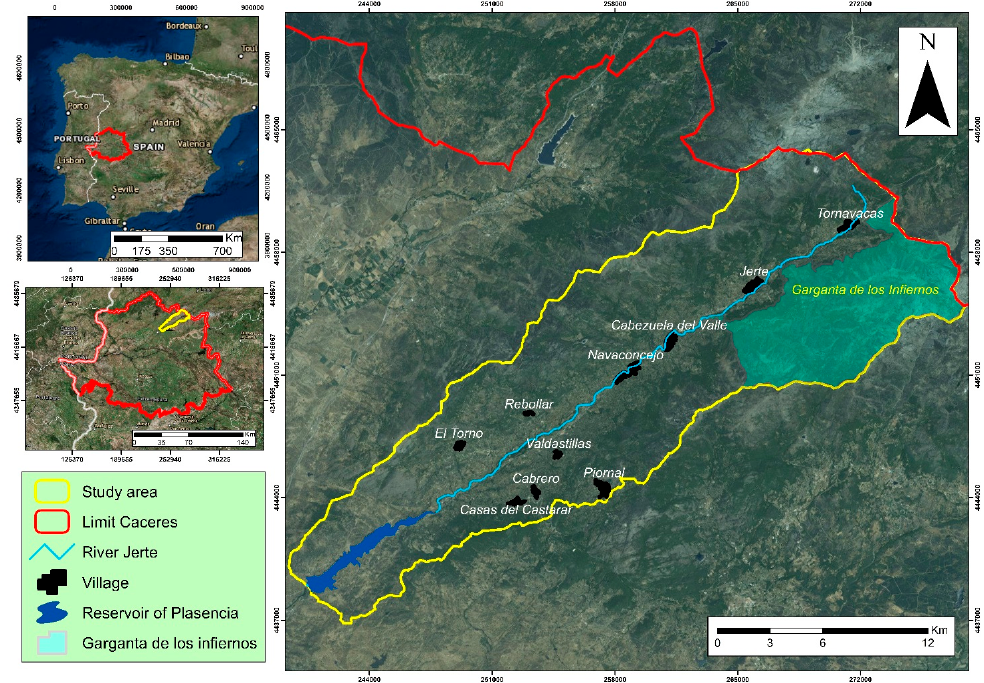
Figure 1. Location of the study area (the Jerte valley) within Cáceres (Spain).